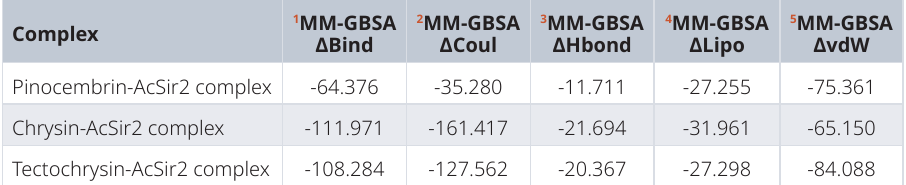
Table 3. Prime MM-GBSA binding free energy values (kcal/mol) of the ligand-protein complexes.